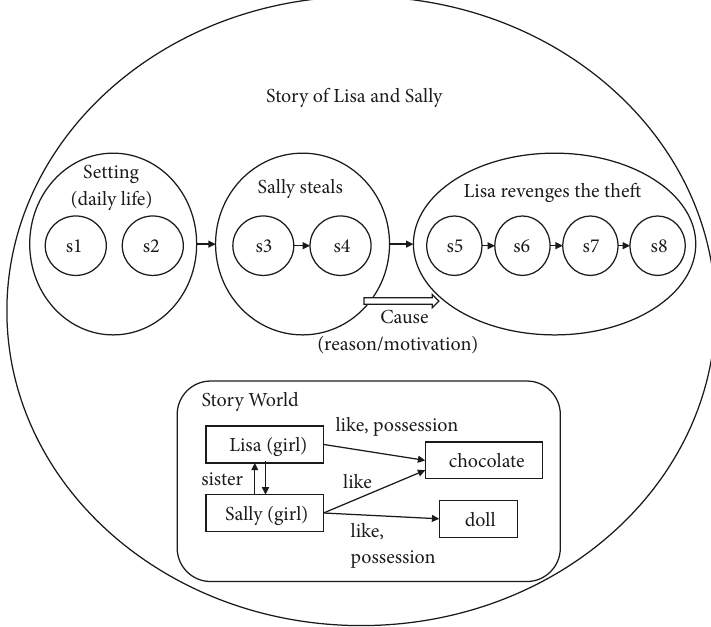
Figure 6: A structural representation of the example story in Box 1 (s1–8 in the small circles correspond to sentences in Box 1).